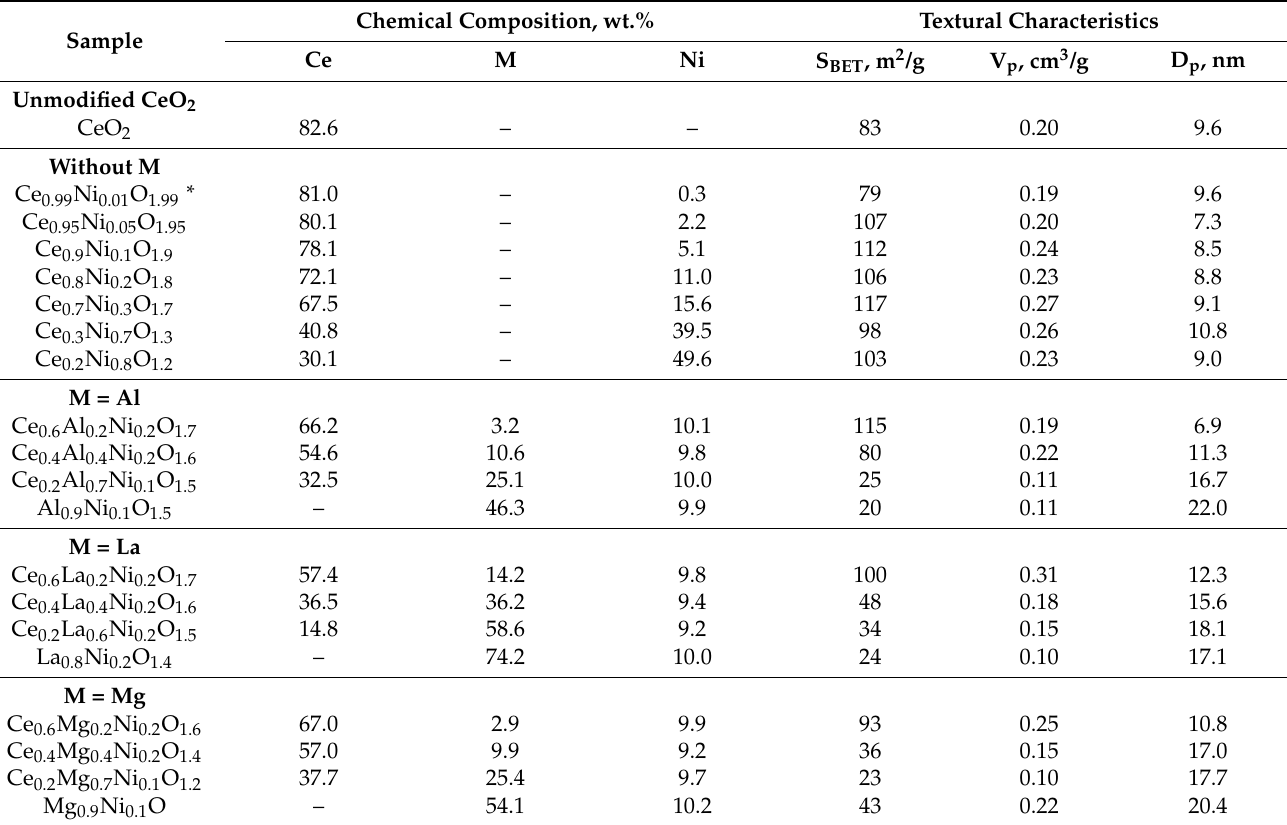
Table 1. Chemical composition and textural properties of (CeM) 1 − x Ni x O y samples.